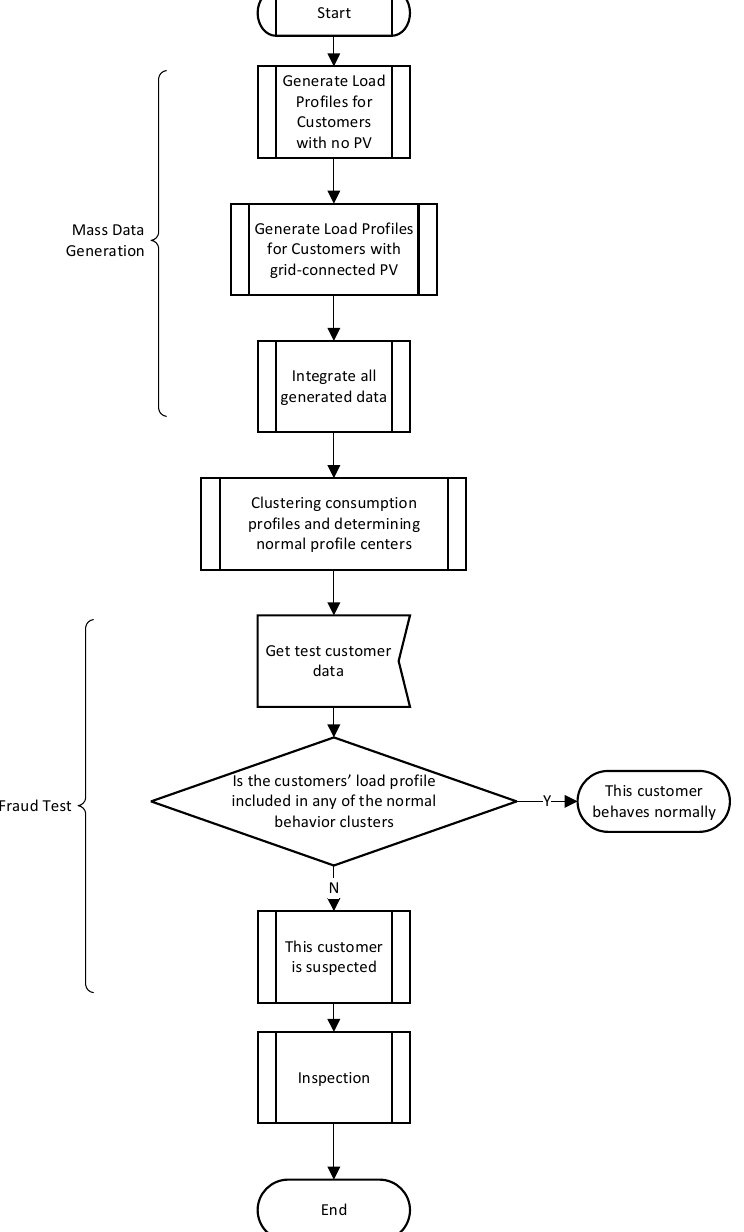
Figure 5. Flowchart of proposed method for fraud detection in power distribution networks.